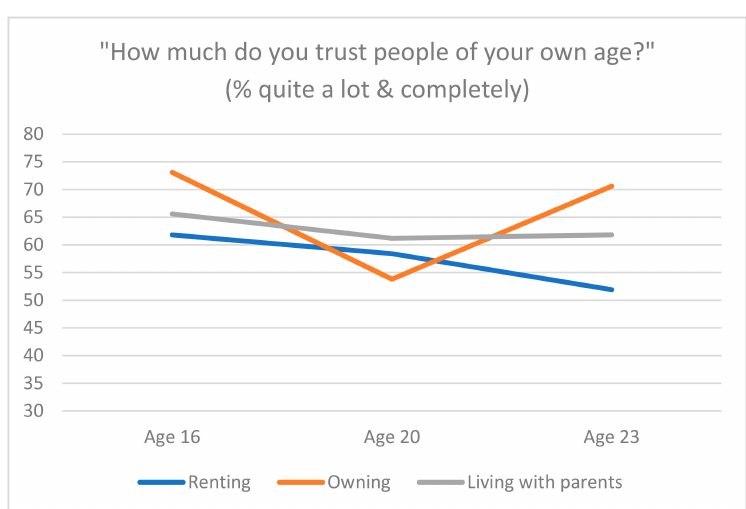
Figure 2. Generalized trust by highest qualification achieved.